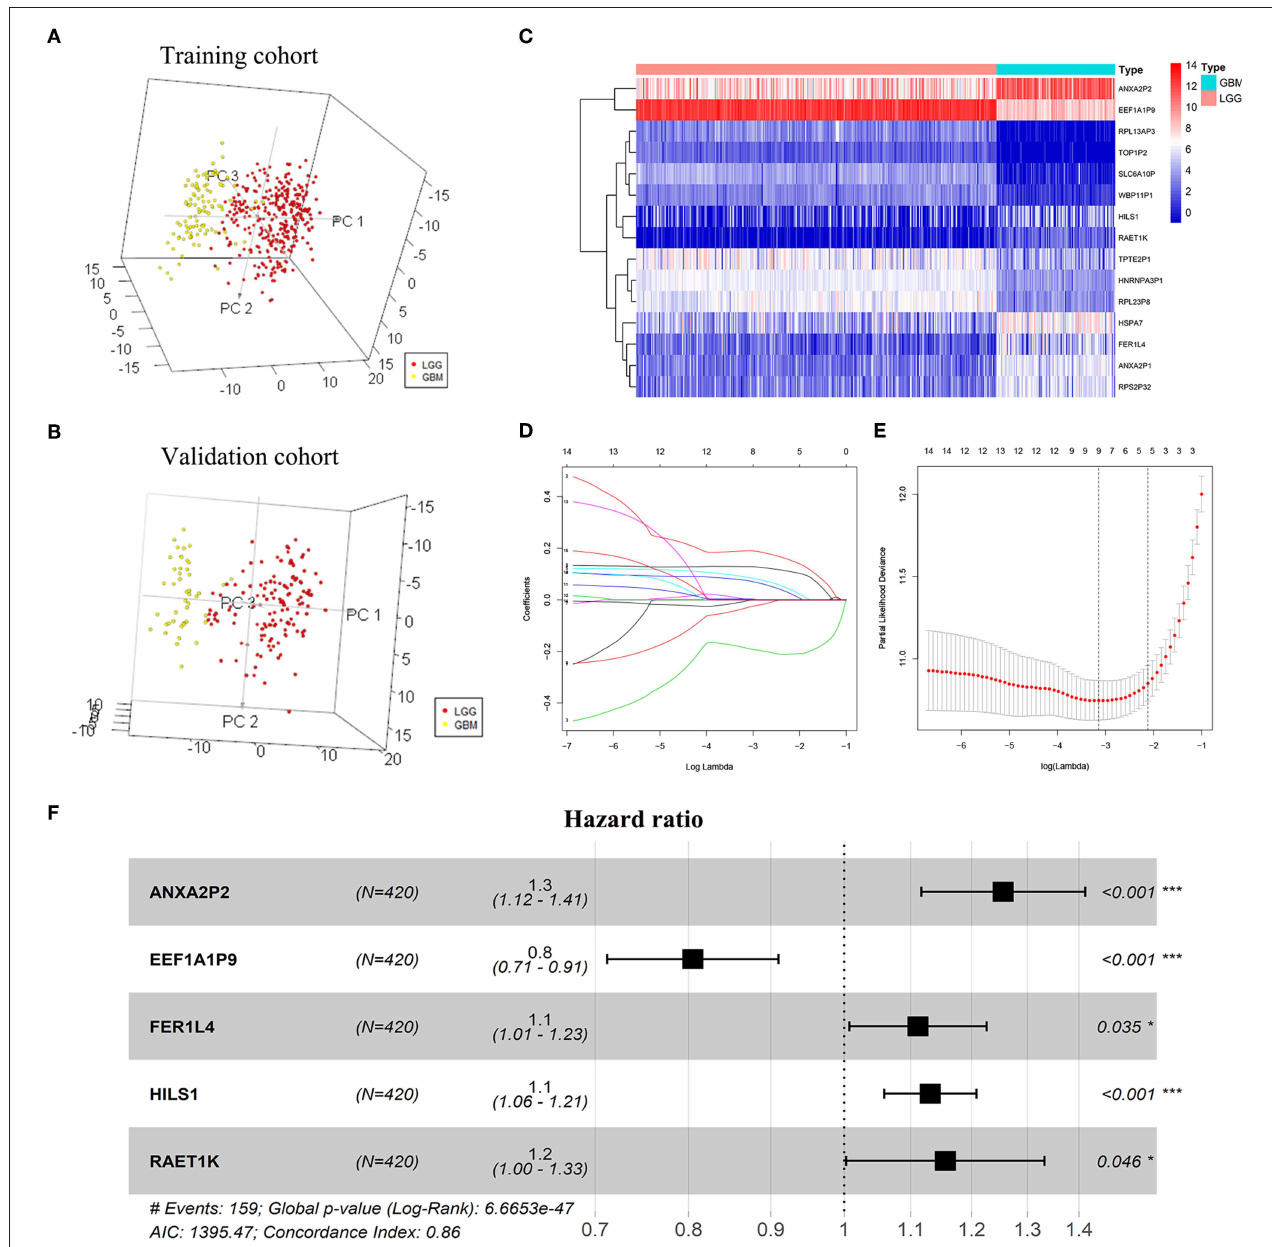
FIGURE 1 | Screening pseudogenes used for constructing the risk signature for glioma. Principal components analysis of pseudogenes between glioblastoma (GBM) and low grade glioma (LGG) in the training cohort (A) and the validation cohort (B) . (C) Heatmap showed the pseudogenes differentially expressed between LGG and GBM in the training cohort (| log2(fold-change) | ≥ 2 and FDR < 0.05). (D) Log (Lambda) value of the 15 pseudogenes in LASSO model. (E) The most appropriate log (Lambda) value in the LASSO model. (F) Multivariate Cox regression analysis was performed and five pseudogenes (ANXA2P2, EEF1A1P9, FER1L4, HILS1, and RAET1K) were selected to construct the risk